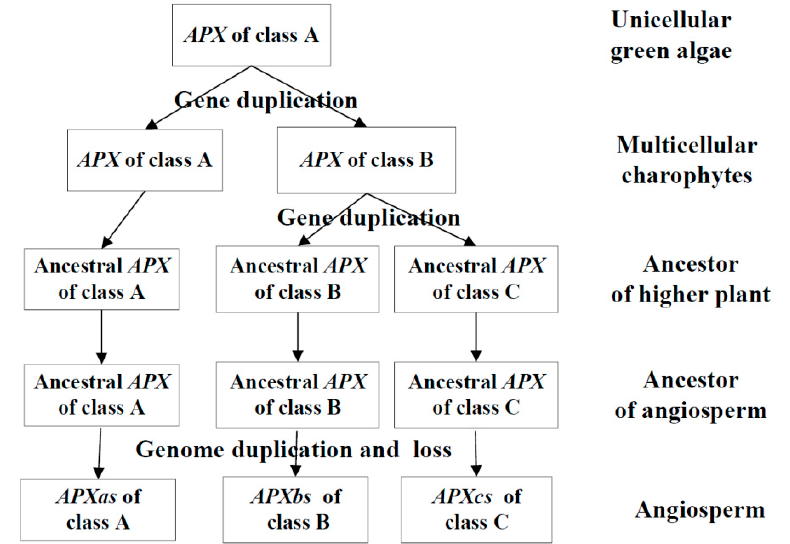
Figure 8. The origin of the angiosperm APX genes. Plant species are mentioned on the right.